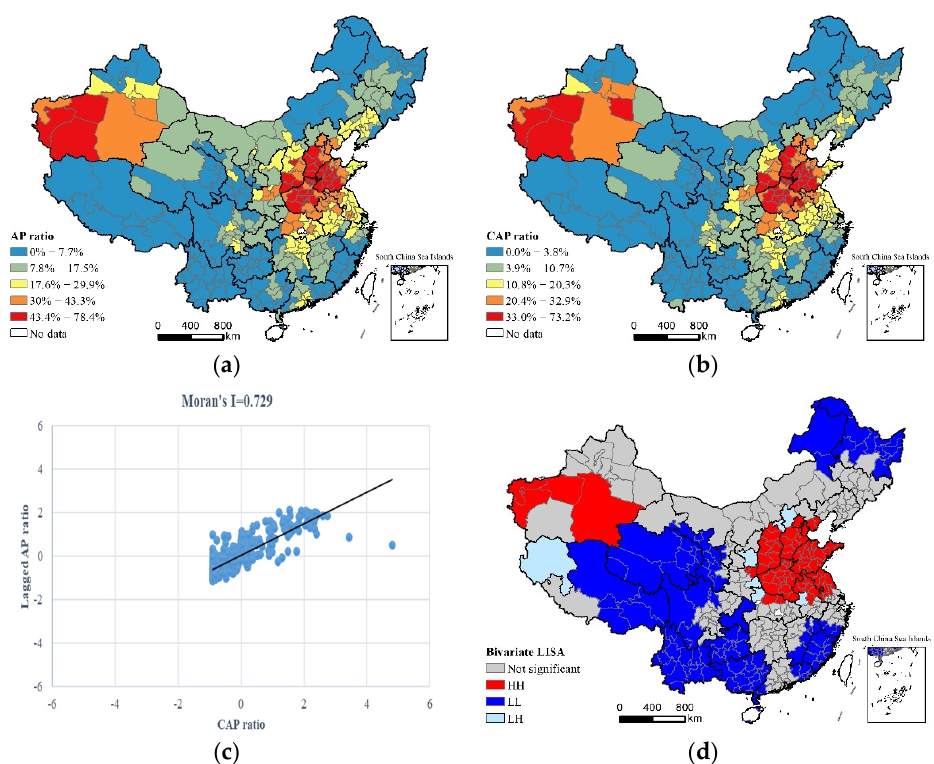
Figure 1. The spatial distribution and correlation characteristics between the proportion of CAP days and the proportion of air pollution days in China: ( a ) spatial distribution of proportion of air pollution days; ( b ) spatial distribution of proportion of CAP days; ( c ) scatter figure of Globe Moran’s I value for proportion of CAP days; and ( d ) bivariate LISA of proportion of CAP days and proportion of air pollution days.